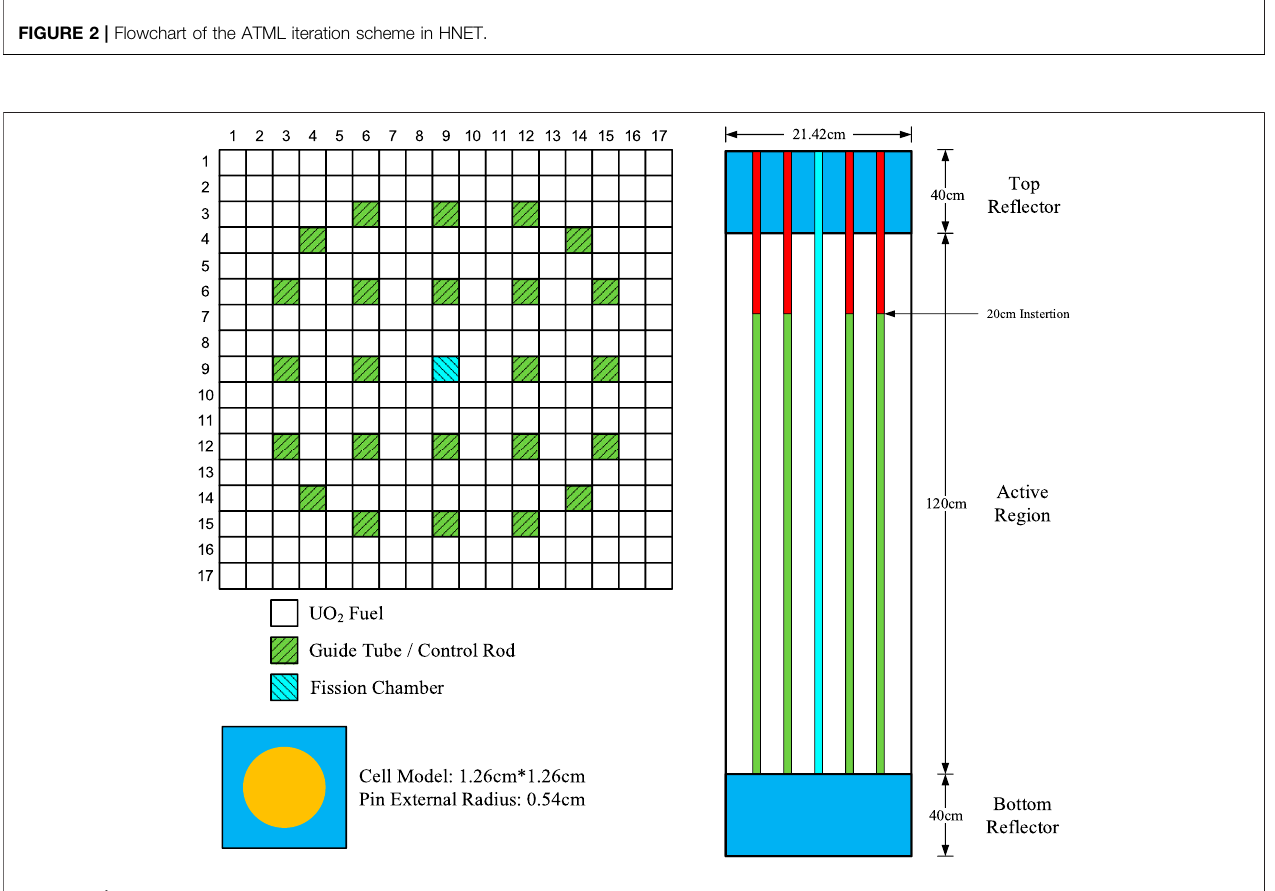
Frontiers in Energy Research |